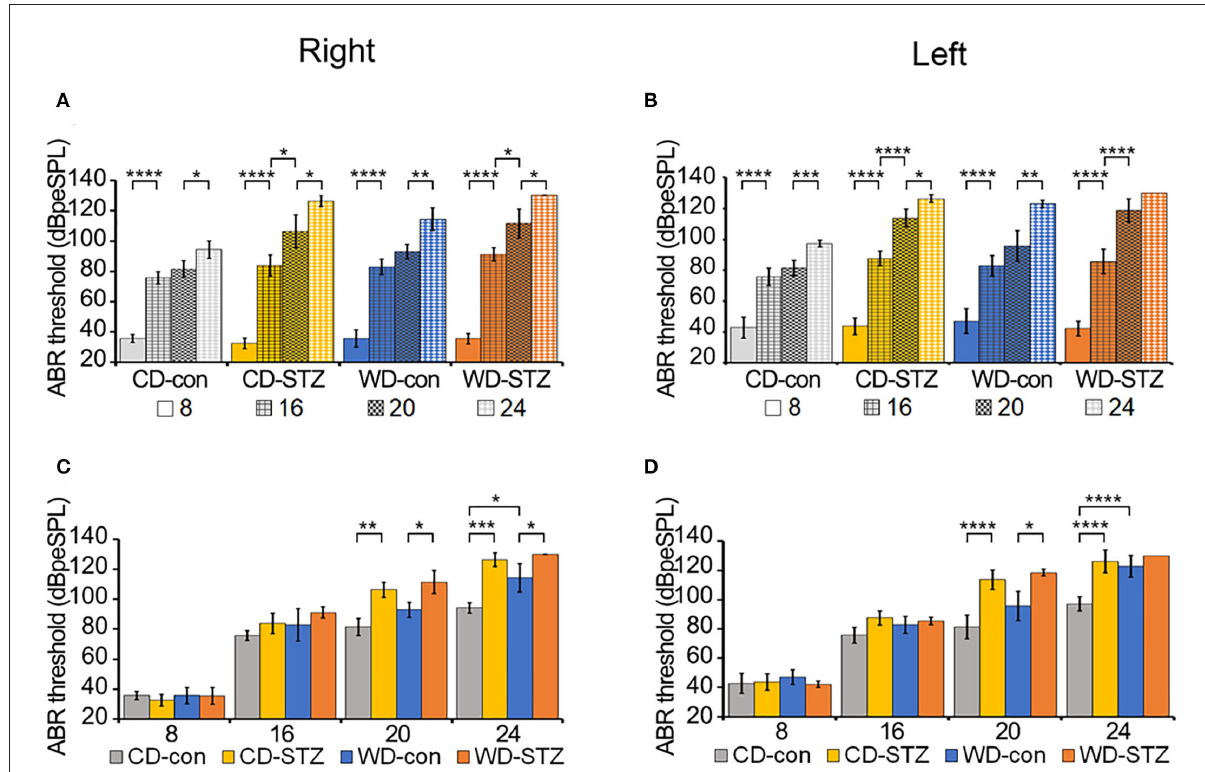
FIGURE6 Hearing ability according to age and experimental conditions. (A,B) Increased auditory brainstem response (ABR) thresholds with age. ABR thresholds were measured in CD-con, CD-STZ, WD-con, and WD-STZ mice at 8, 16, 20, and 24 weeks of age with click sounds to compare age differences between each group in the right (A) and left (B) ears. (C,D) Increased ABR thresholds due to Western diet (WD) feeding and streptozotocin (STZ) treatment. ABR thresholds were measured in CD-con, CD-STZ, WD-con, and WD-STZ mice at 8, 16, 20, and 24 weeks of age with click sounds to compare differences between groups at the same age in the right (C) and left (D) ears. * p < 0.05, ** p < 0.01, *** p < 0.001, and **** p < 0.0001.